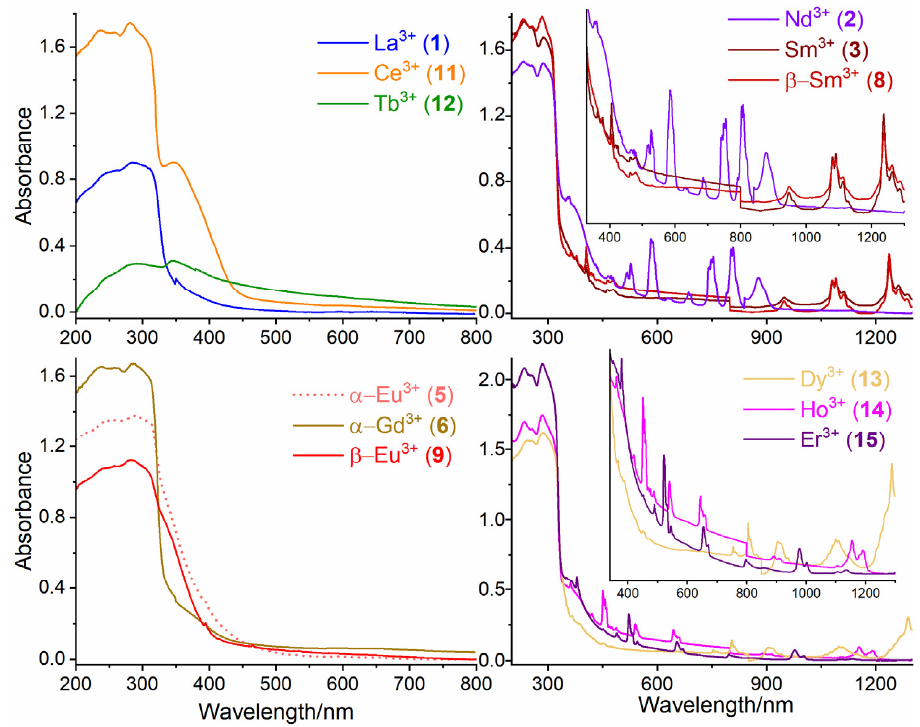
Figure 6. Solid-state absorption spectra of 1 ∞ [Ln 2 (2–PyPzH) 4 Cl 6 ], Ln = La ( 1 ), Nd ( 2 ), Sm ( 3 ), α –[Ln 2 (2– PyPzH) 4 Cl 6 ], Ln = Eu ( 5 ), Gd ( 6 ), β –[Ln 2 (2–PyPzH) 4 Cl 6 ], Ln = Sm ( 8 ), Eu ( 9 ), [Ce(2–PyPzH) 3 Cl 3 ] ( 11 ), and [Ln(2–PyPzH) 2 Cl 3 ], Ln = Tb ( 12 ), Dy ( 13 ), Ho ( 14 ), Er ( 15 ) at room temperature. Table 1. Absorption wavelengths of the transitions of 1 ∞ [Ln 2 (2–PyPzH) 4 Cl 6 ], Ln = Nd ( 2 ), Sm ( 3 ), α – [Eu 2 (2–PyPzH) 4 Cl 6 ] ( 5 ), β –[Ln 2 (2–PyPzH) 4 Cl 6 ], Ln = Sm ( 8 ), Eu ( 9 ), and [Ln(2–PyPzH) 2 Cl 3 ], Ln = Dy